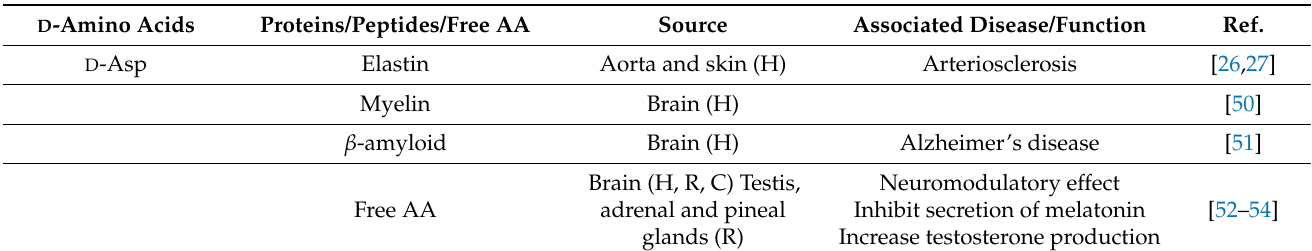
Table 2. List of various D -amino acids in higher organisms, their location and associated roles. Reproduced with permission from the authors of